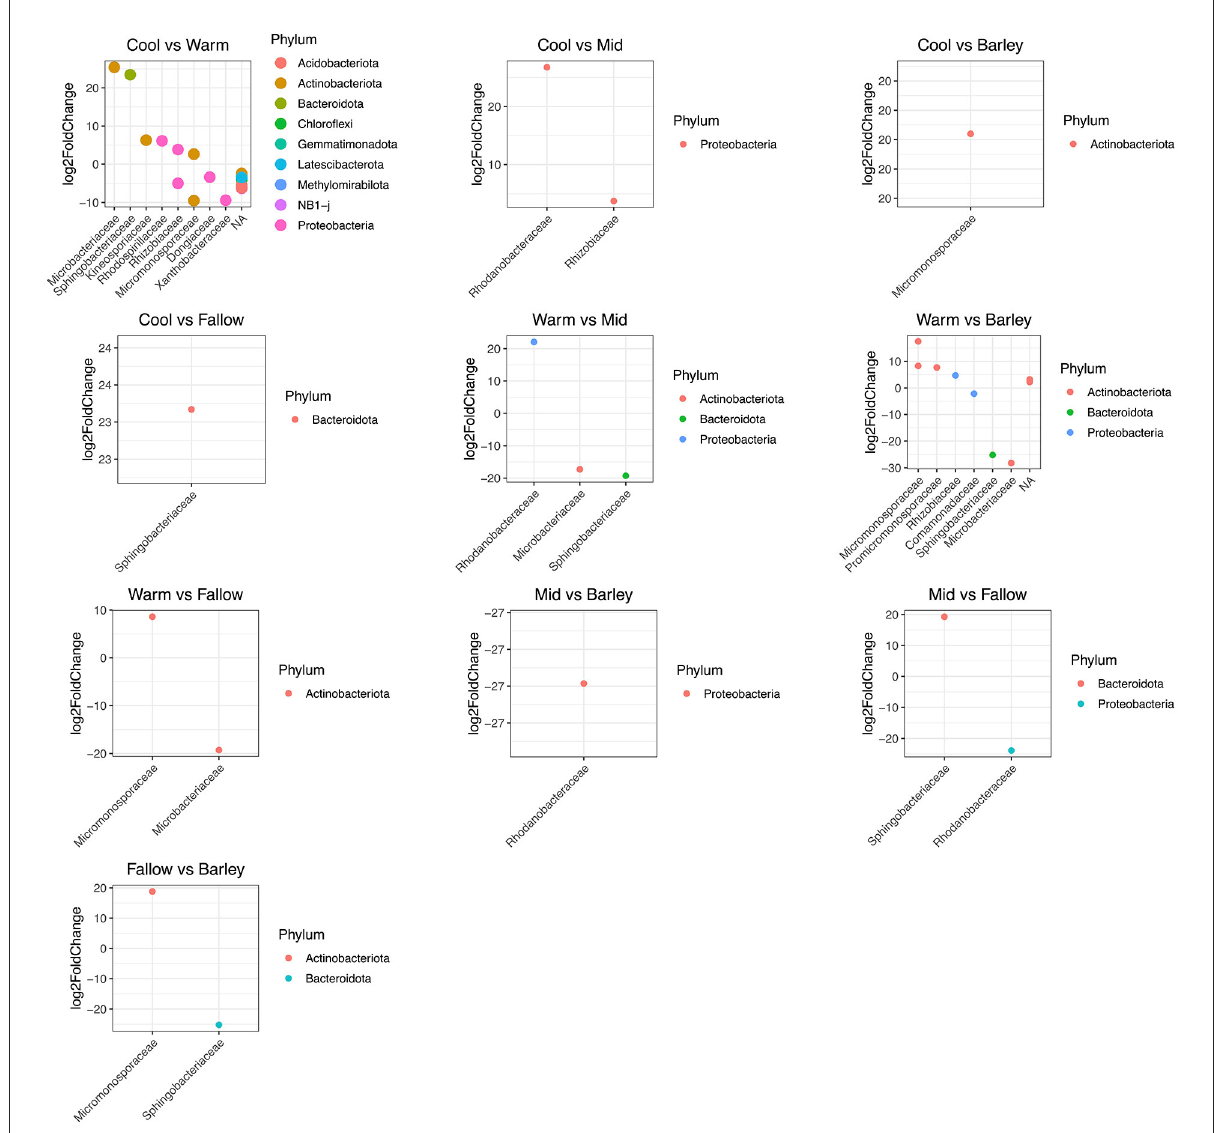
FIGURE3 Plot of differentially abundant taxa. Cover crop treatment comparisons are shown above each plot. Significantly different ( p < 0.05, FDR corrected) taxa are colored by phylum while the taxonomic rank at the family level is shown on the x-axis.